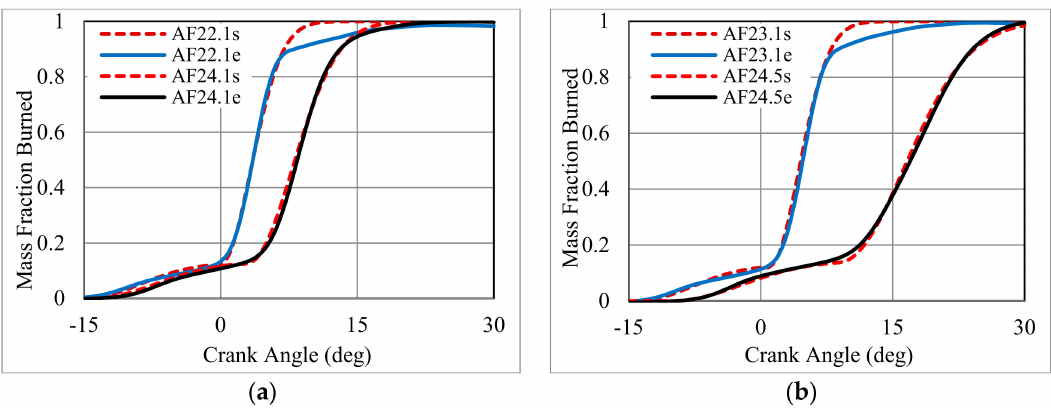
Figure 9. Comparison of MFB curves between simulated and experimental results: ( a ) AFR = 22.1 and 24.1; and ( b ) AFR = 23.1 and 24.5.